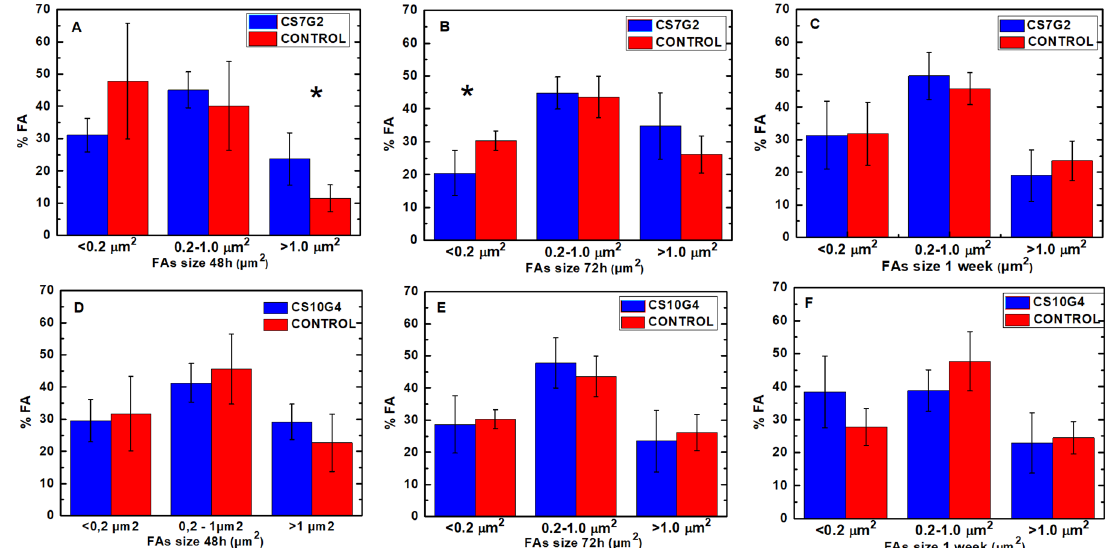
Figure 11. Percentage of FAs according to size. Comparative analysis between cells grown on CS7G2 and control groups at ( A ): 48 h hours in culture; ( B ): 72 h hours in culture; ( C ): 1 week in culture; and cells grown on CS10G4 and controls in ( D ): 48 h hours in culture; ( E ): 72 h hours in culture; ( F ): 1 week in culture (*: p < 0.005).